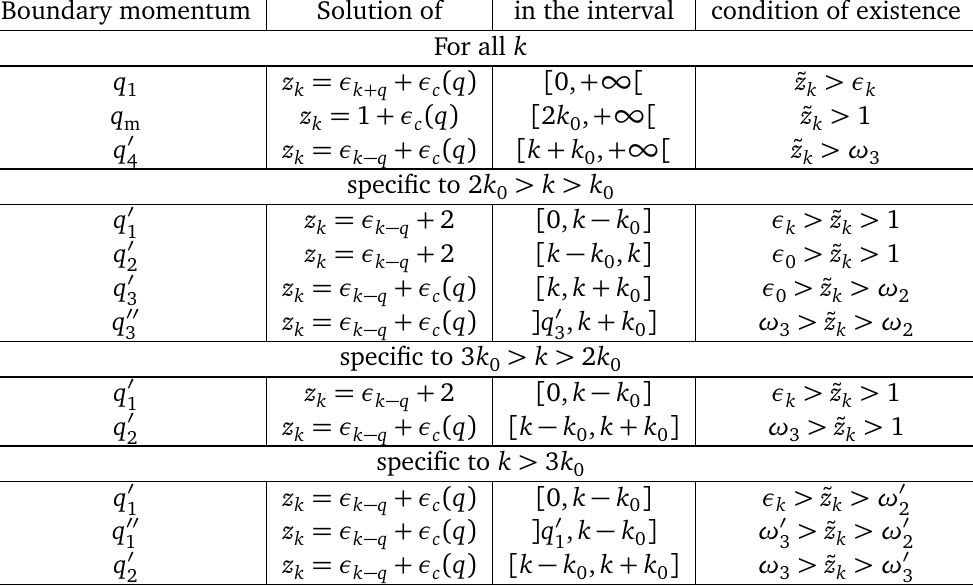
Table 5: Table of the boundary momenta (used in Table 3) in the region k > k Boundary